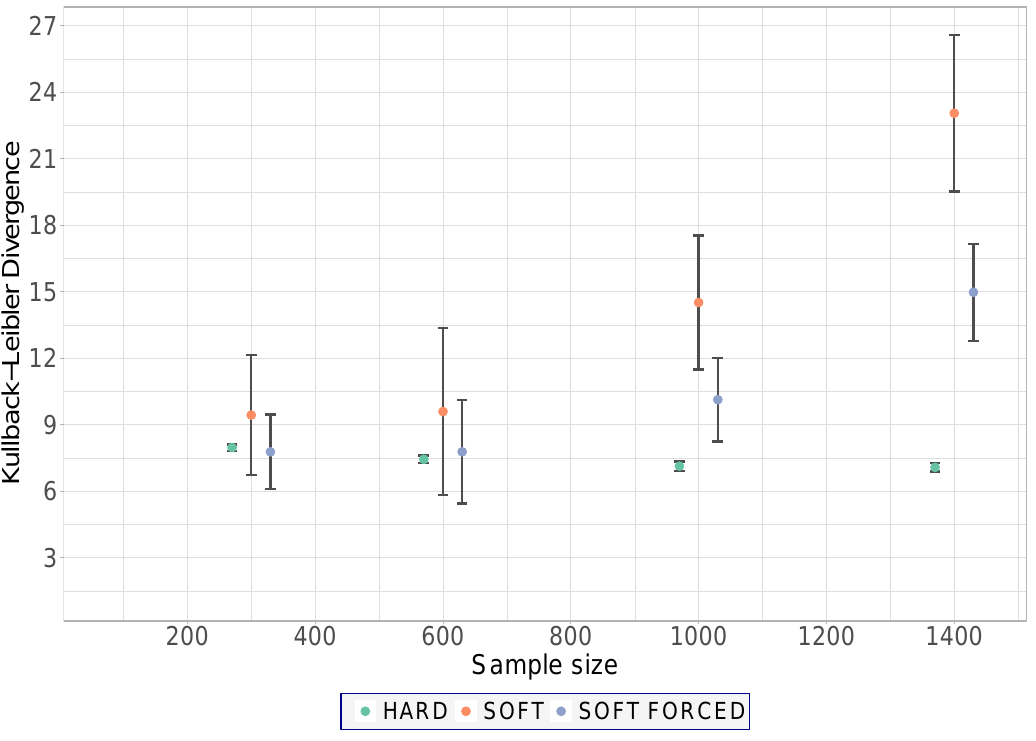
Figure 4. Leaf E. Hard EM achieves a value of KLD which is significantly smaller than that achieved by other EM algorithms (data sets with 1% missing data generated from the Formed BN).